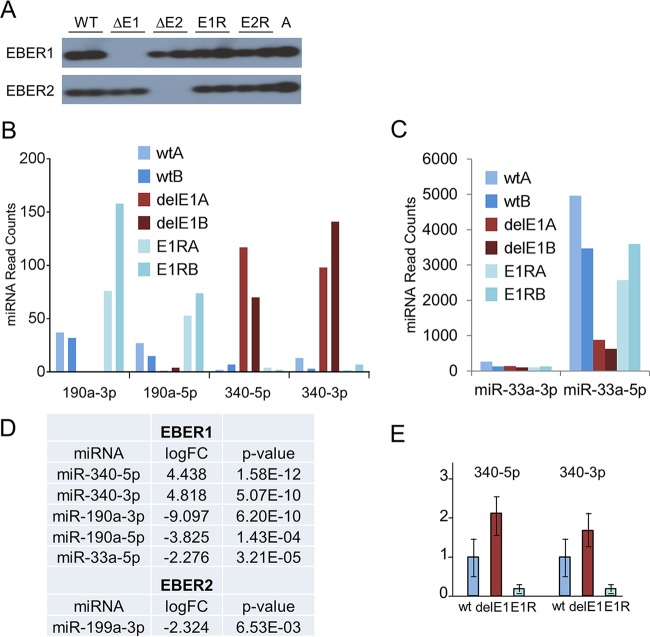
(A) EBER1 and EBER2 expression in the wt and EBER-deleted LCLs used for deep sequencing analysis was confirmed by Northern blotting (1). A 0.5-μg volume of total RNA was used per well. (B) Normalized miRNA read counts for miR-190a and miR-340 in EBER1-deleted (delE1) LCLs compared to wild-type (wt) and EBER1 revertant (E1R) LCLs. “A” and “B” denote the two individual LCLs analyzed for each condition. About 10 million sequencing reads were obtained for each LCL library. Reads were processed as described previously (6) using scripts from the fastx toolkit (http://hannonlab.cshl.edu/fastx_toolkit/). To determine miRNA levels, reads were aligned to the human (HG19) and EBV B95-8 genomes and annotated according to mirbase v21 (http://www.mirbase.org/). To determine miRNA expression levels, miRNA read counts were obtained using the quantifier module of miRDeep2 (14) (see Table S1 in the supplemental material). To identify differentially expressed (DE) miRNAs, miRNA read counts were analyzed by edgeR using trimmed mean of M (TMM) values for normalization (15, 16). For inclusion in the analysis, a minimum of 40 reads per miRNA in at least one of the 10 LCL libraries was required. DE miRNAs with a LogFC P value of <0.05 are reported in Table S2. (C) Normalized miRNA read counts for miR-33a in EBER1-deleted LCLs. (D) Summary of log fold changes (logFC) of selected cellular miRNAs showing significant changes correlating with EBER1 or EBER2 expression as determined by deep sequencing and edgeR analysis. (E) Relative levels of miR-340-5p and miR-340-3p determined by TaqMan qRT-PCR assays in LCLs. The expression levels of miRNAs were normalized to RNU48. The values represent means ± standard errors (SE) of the results of analysis of 6 independent samples per EBV type (5 in the case of EBER1 revertants). The wild-type expression levels were set to 1 for each miRNA, whereas the levels of other samples were expressed relative to the wild-type level. Each cDNA sample was analyzed in triplicate.